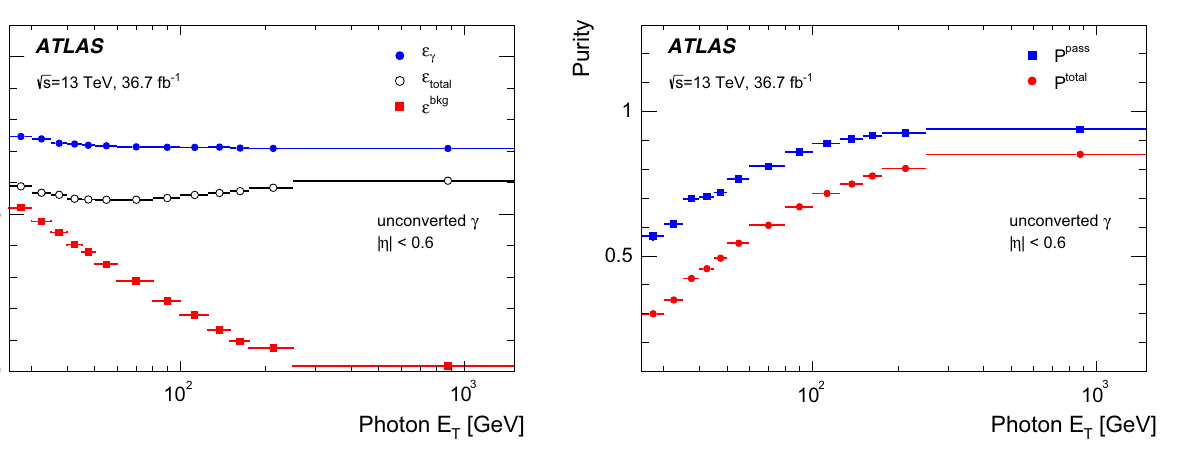
The P total curve on the right plot is obtained from the (cid:13) total curve rel- ative to the (cid:13) γ and (cid:13) bkg ones in the left plot, following Eq. (1). In both plots statistical uncertainties are shown as error bars but are generally not